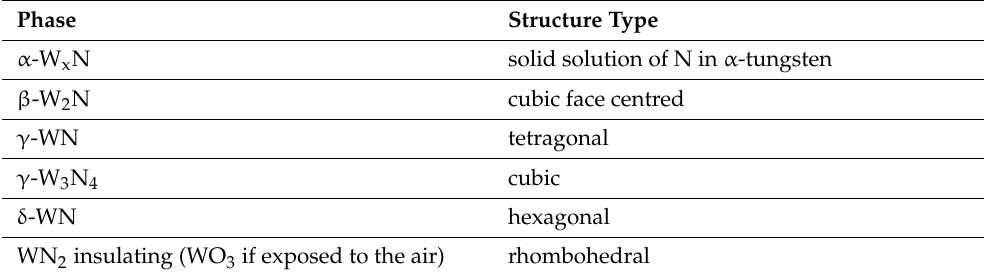
Table 1. Phases of tungsten nitride and their structure